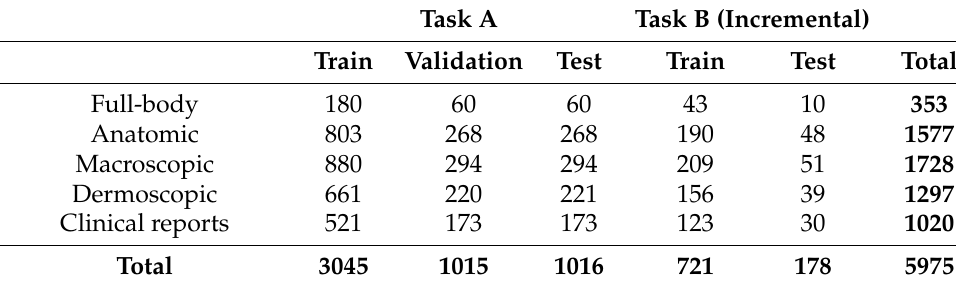
Table 1. Dataset distribution according to the different